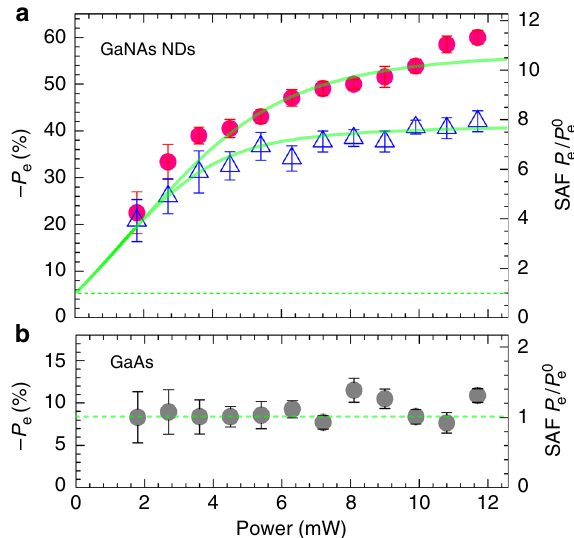
= P 0 from the GaNAs e e e from GaAs is also shown by the gray symbols. The vertical